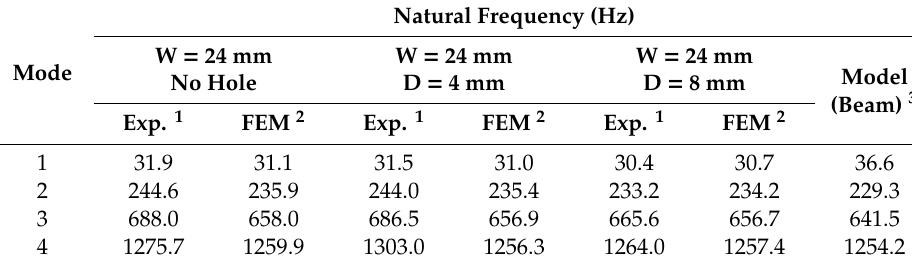
Table 5. Comparison of the natural frequency of a uniform composite rectangular cantilever beam (W = 24 mm) with experimental and FEM results for samples of the same